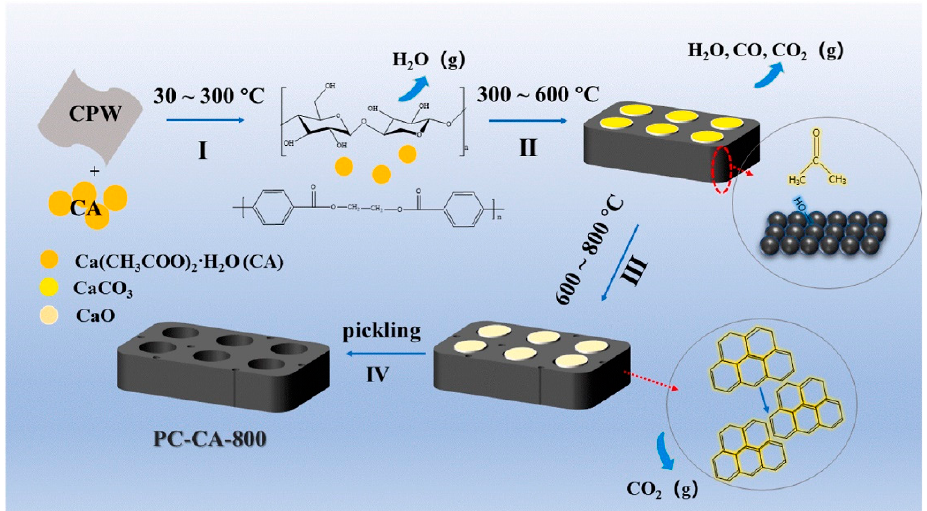
Figure 11. Schematic representation of carbon porous structure formation, at the pyrolysis of a cotton-polyester waste (CPW) in the presence of calcium acetate, reprinted with permission from Ref. [111].